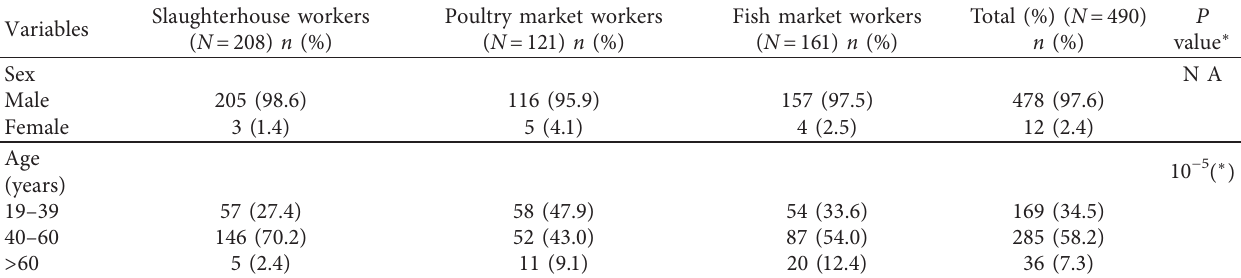
Table 1: Demographic characteristics of workers participating in the leptospirosis study in Casablanca (Morocco) ( N � 490).